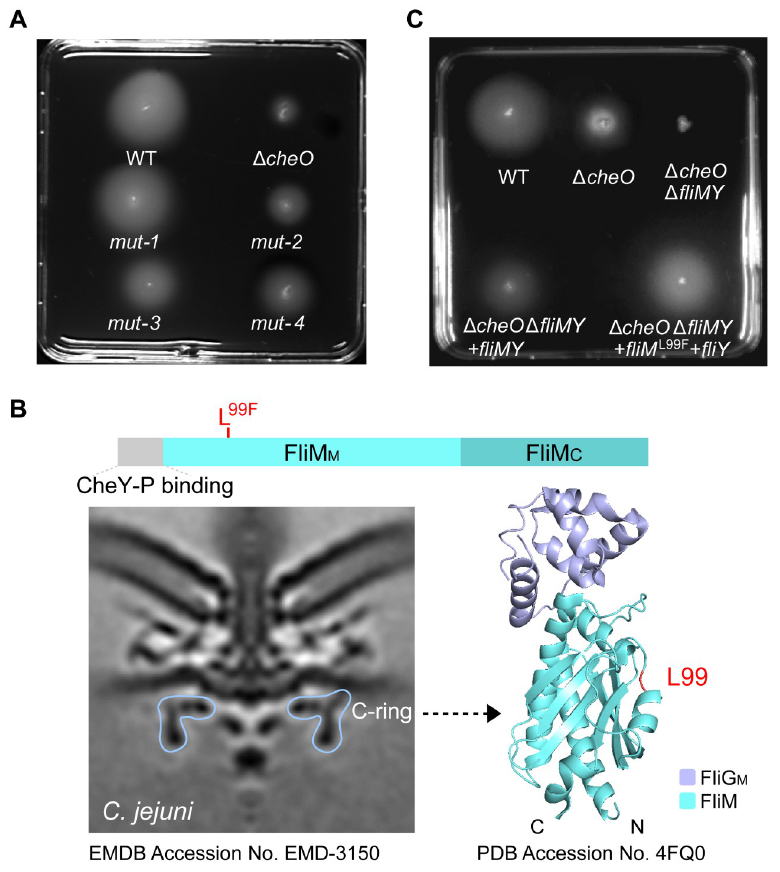
Fig 5. Analysis of C . jejuni Δ cheO suppressor mutants in microaerobic condition. (A) Soft agar motility assay of C . jejuni wild-type, parental Δ cheO mutant and Δ cheO isogenic suppressor mutants “mut-1” to “mut-4”. (B) The C-ring of C . jejuni flagellar motor, domain architecture and X-ray structure of FliM. FliM M : the middle domain of FliM; FliM C : the C terminal domain of FliM [45,54]. (C) Soft agar motility phenotypes of C . jejuni wild-type and the relative isogenic mutants in microaerobic conditions.